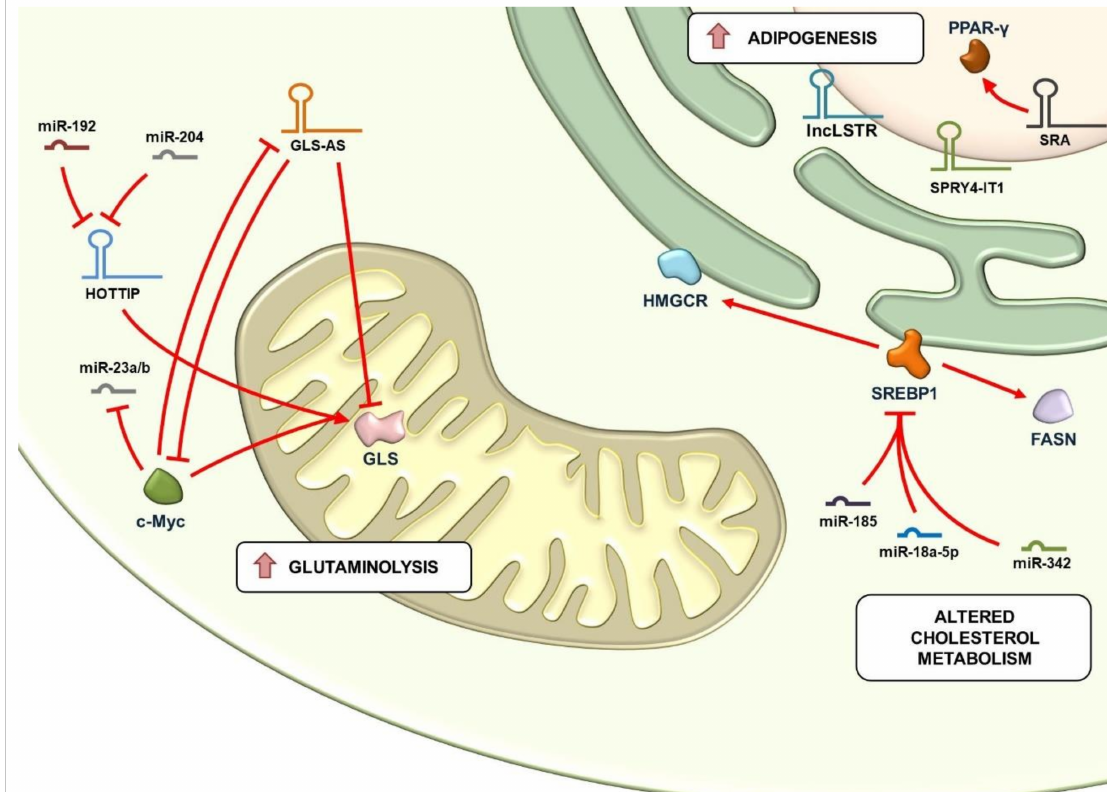
Figure 3. Mitochondrial and lipid metabolism are profoundly influenced by non-coding RNAs in cancer cells. The accelerated energetic demand of cancer cells is regulated by the mitochondrial enzyme glutaminase (GLS), a crucial molecular switch whose activity is finely regulated by nRNAs; miR-192 and miR-204, as an example, enhance the